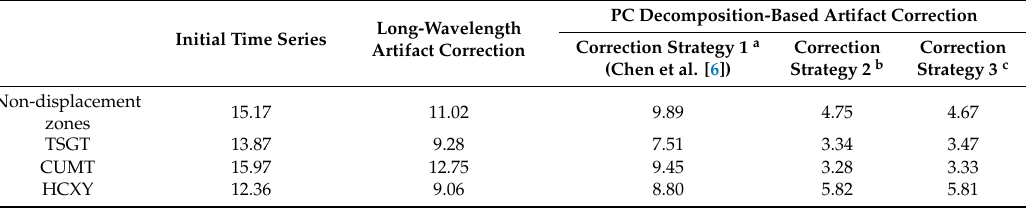
Table 2. Comparison of the root mean squares (RMS) in non-displacement zones and the RMS of the di ff erences between GNSS and InSAR derived from di ff erent correction strategies